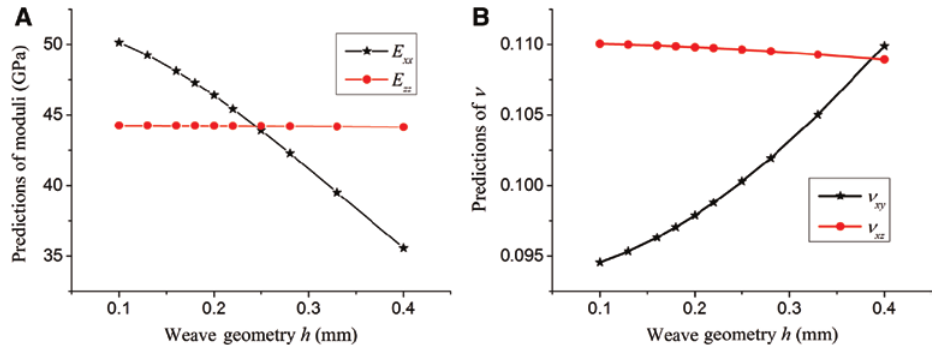
Figure 23: Effect of h on predicted values.